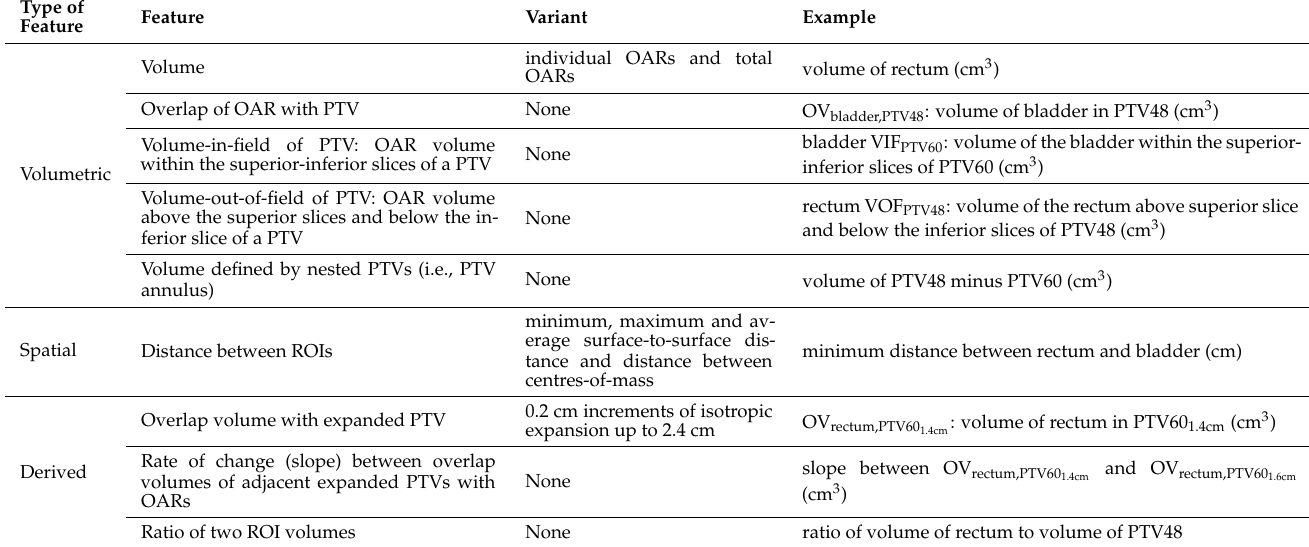
Table 5. Summary of variables considered for FeatureDS1 and FeatureDS2. Features fall into three categories: volume related (volumetric), distance related (spatial) and derivations of volumetric and/or spatial (derived). Variants are denoted where multiple features of their kind are